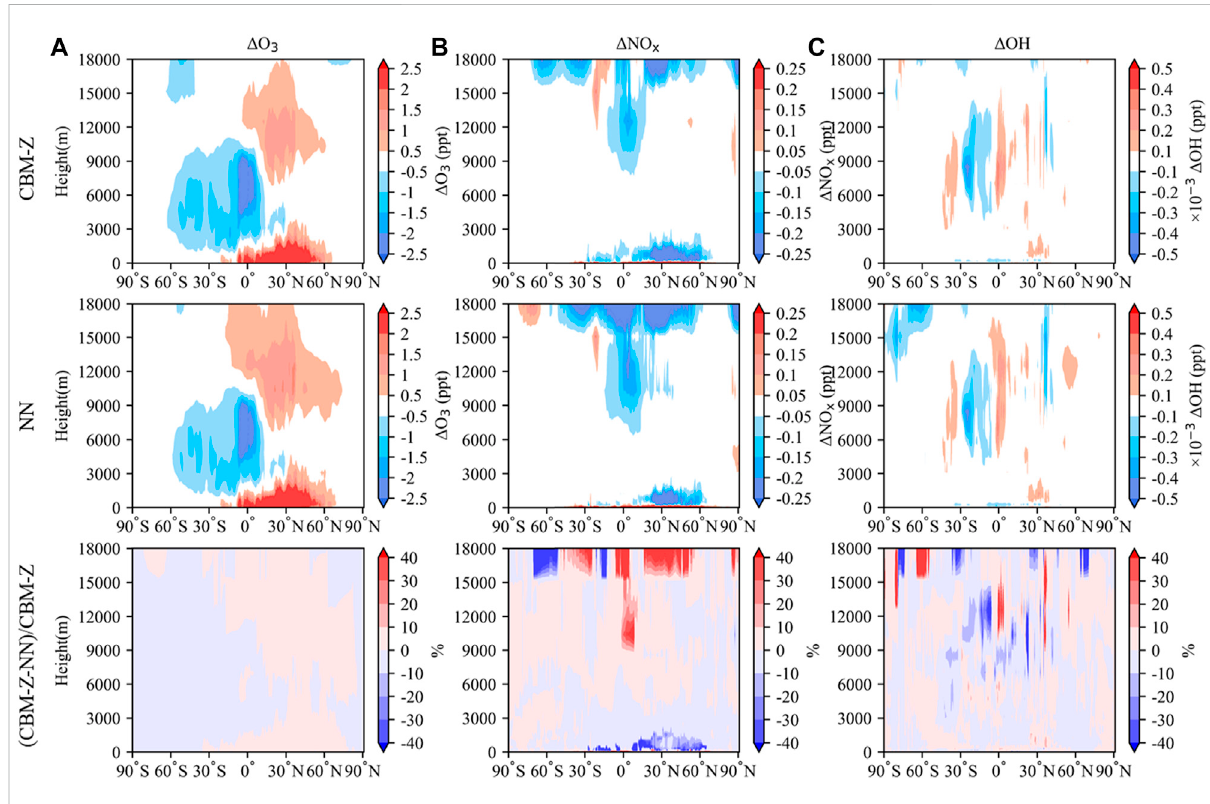
FIGURE 6 Vertical section of concentration changes of O 3 (A) , NO x (B) and OH (C) at 5:00-5:20 UTC simulated by CBM-Z module and neural network (NN) emulator and the deviation of the predicted values of the two